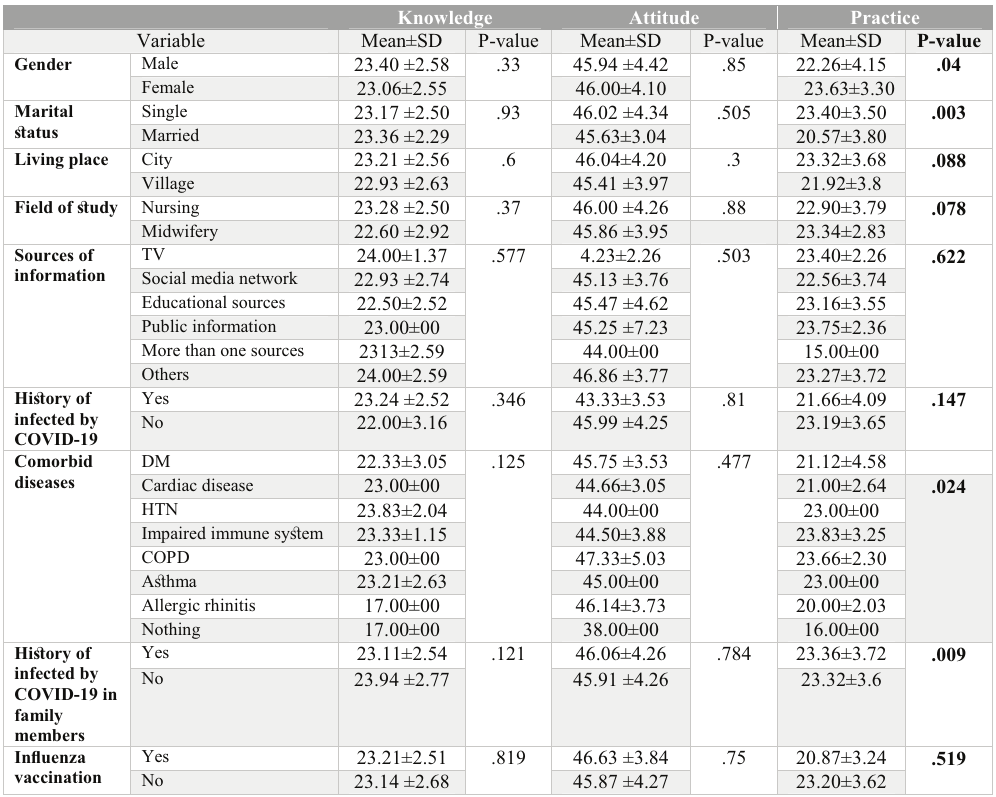
Table 2: The knowledge, attitude and practice for prevention of COVID-19 disease among students based on demographic and clinical